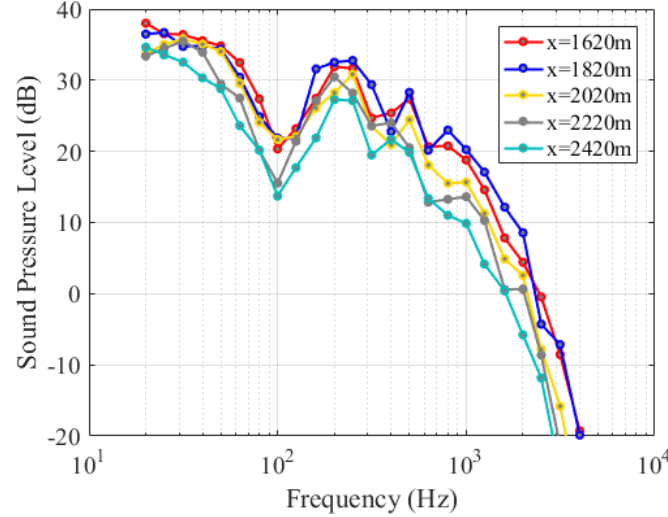
Figure 20. Total SPL from wind turbines #1, 2, 3 received at various distance.